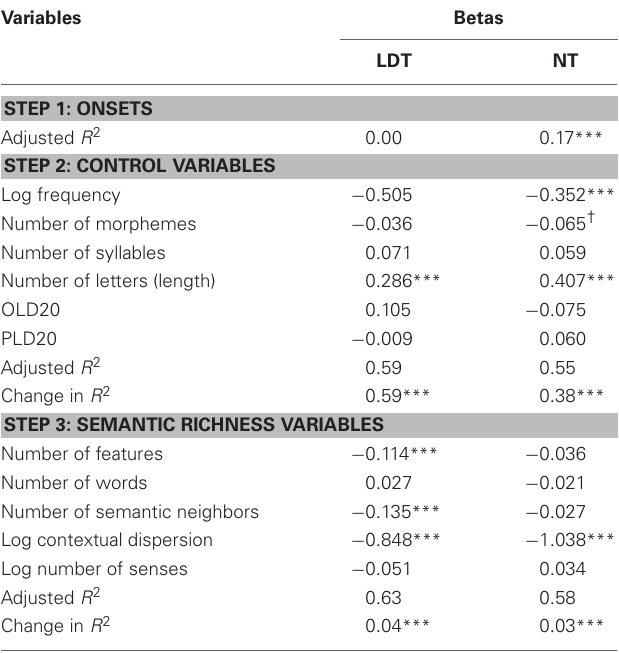
Table 3 | Standardized regression coefficients predicting lexical decision and naming latencies, using number-of-features measure derived from data collected in Analysis